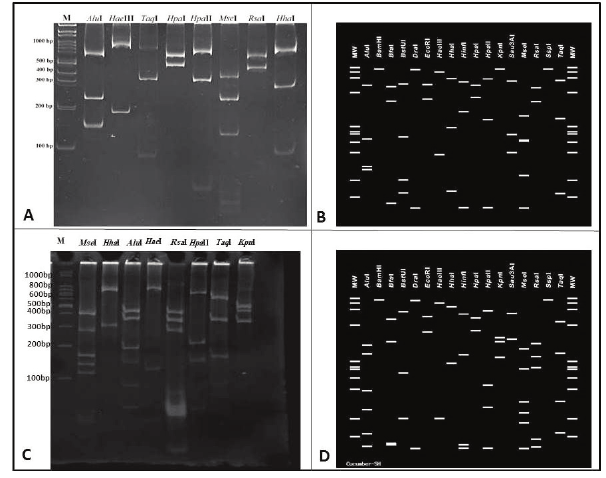
Fig. 2 ­ Real and virtual RFLP patterns (Zhao et al ., 2009) respec­ tively of 1.2 kb amplicons from TGCP (A and B) and SGCP (C and D) phytoplasma strains 16S ribosomal gene sequence. Lane M, 100 bp DNA ladder (Biobasic, Canada). DNA products were digested with the enzymes listed at the top of the